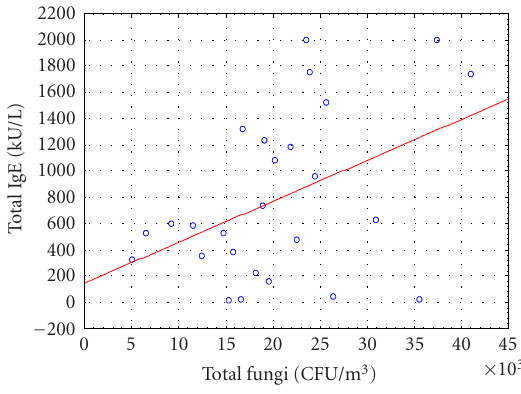
Figure 1. The relationship between total airborne fungal con- centrations and serum total IgE levels. Y = 144 . 9138+0 . 0312 ∗ X, r 2 = 0 . 1925; r = 0 . 4388 ,P = .